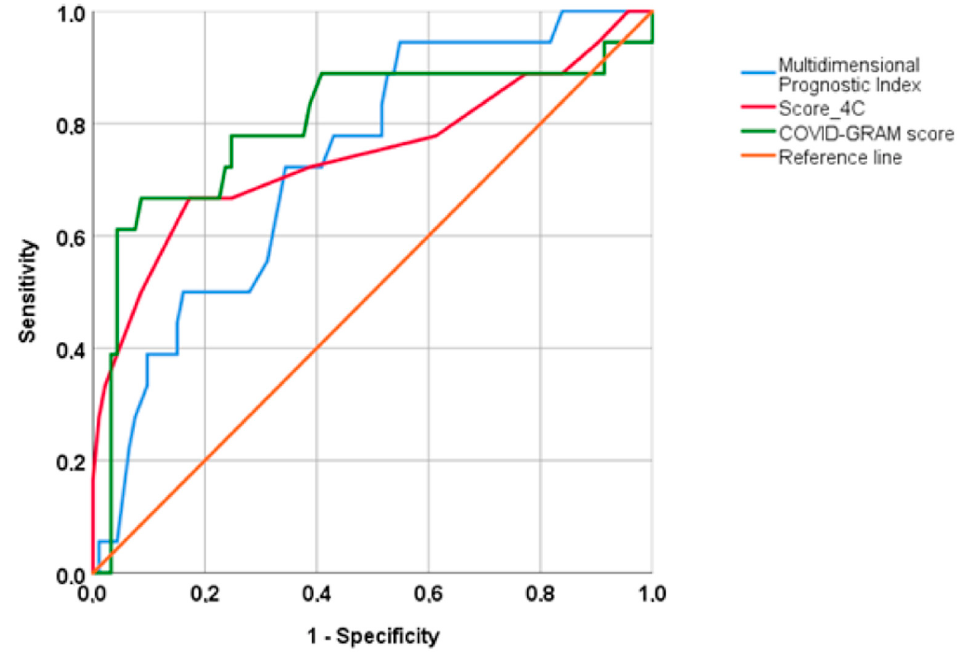
Figure 2. Accuracy of multidimensional prognostic index, 4C score and COVID-GRAM.